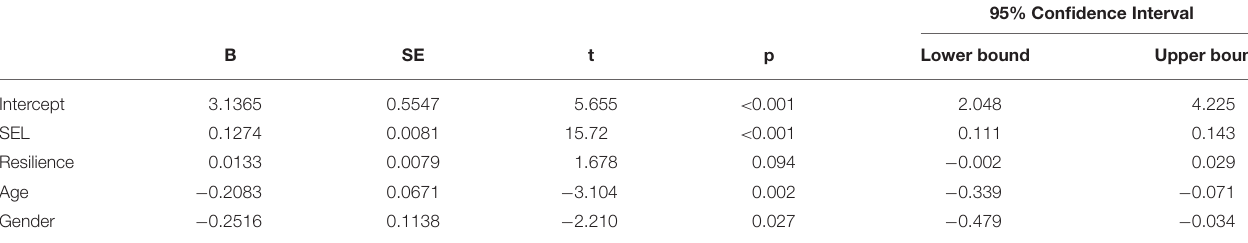
TABLE 4 | Regression outcomes for the target variable Prosocial